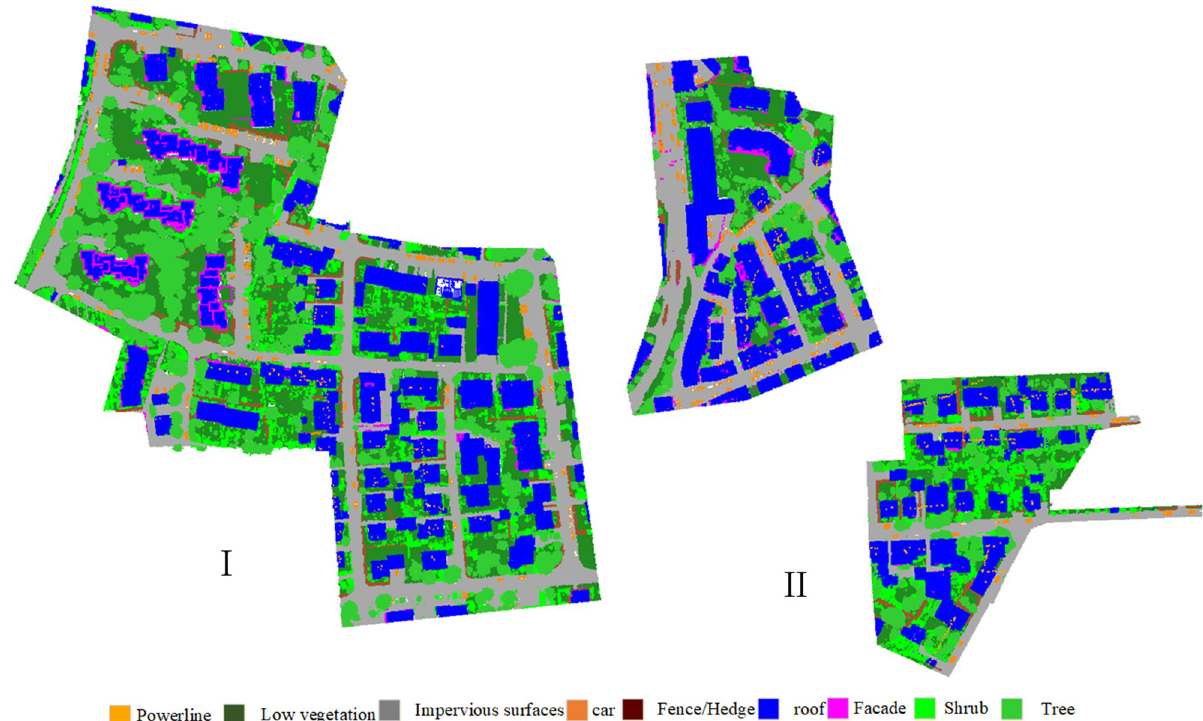
Fig 2. Overview of the ISPRS Vaihingen 3D labeling benchmark dataset. The legend at the bottom indicates the classification labels rendered in colours. https://doi.org/10.1371/journal.pone.0280346.g002 line, low vegetation, impervious surfaces, car, fence, roof, fac¸ade, shrub and tree. The overview of the ISPRS Vaihingen 3D dataset is shown in Fig 2. The Vaihingen benchmark dataset contains three blocks. Scene (I) is used for training, and scene (II) is utilised for evaluation. The point data number for training is 753876, and the number for testing is 411722. The proportion in different categories is shown in Table 1. Table 1 shows that the proportion of the power line category accounts for only 0.07%, whereas the impervious surfaces category accounts for 25.70%. The proportions in different categories are extremely uneven. Training directly on this dataset can be misleading. Following the evaluation metric of the ISPRS 3D benchmark dataset, we use three metrics to evaluate our method, i.e. F1 score, Overall Accuracy (OA) and mean intersection over union (MIoU). MIoU is used to measure the classification performance for all categories. F1 score is calculated from the precision and recall values. It is suitable for classification evaluation in uneven class distribution. The calculations of precision, recall, F1 score and MIoU are